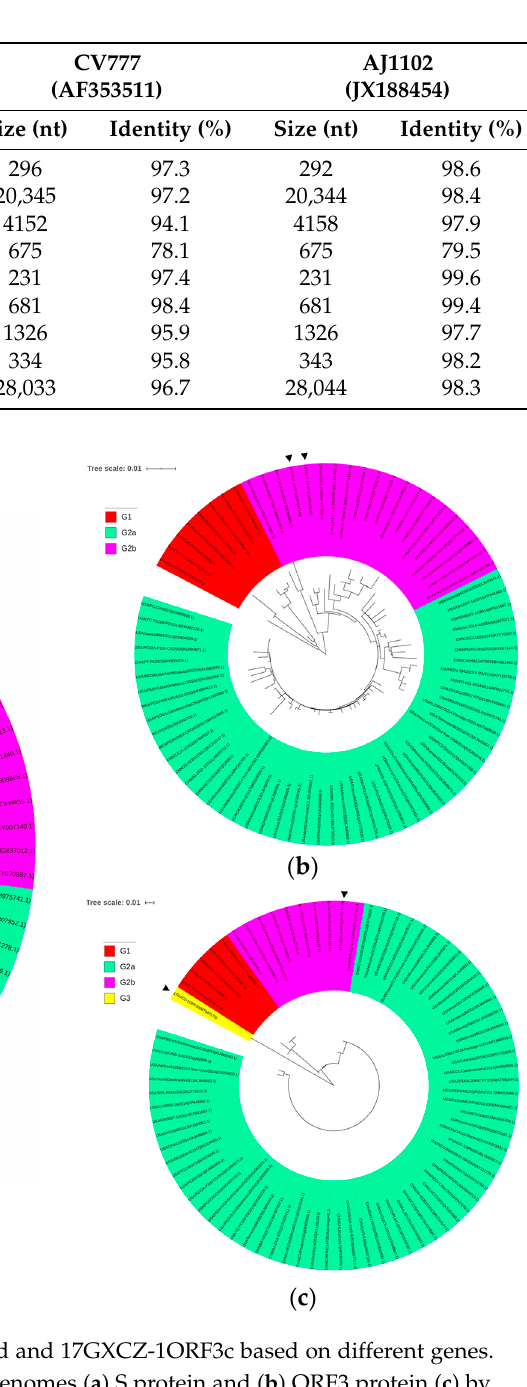
Table 1. Comparisons of the nucleotide sequences of the genome organization of the 2017 Guangxi isolates and their genogroup representative PEDV strains.